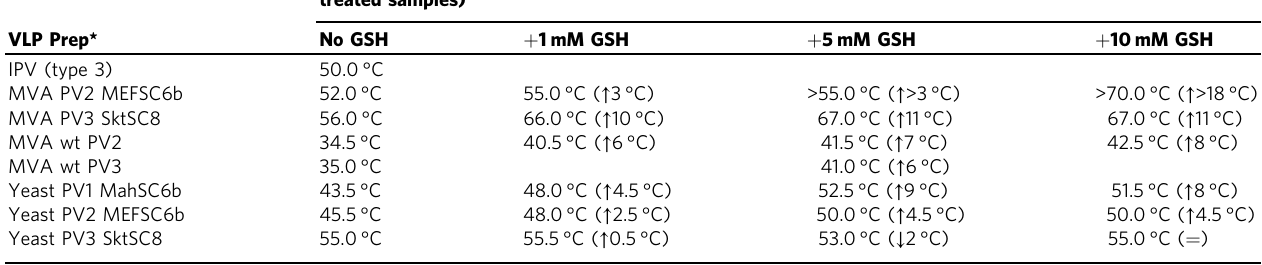
Table 3 Effect of GSH on PV VLP